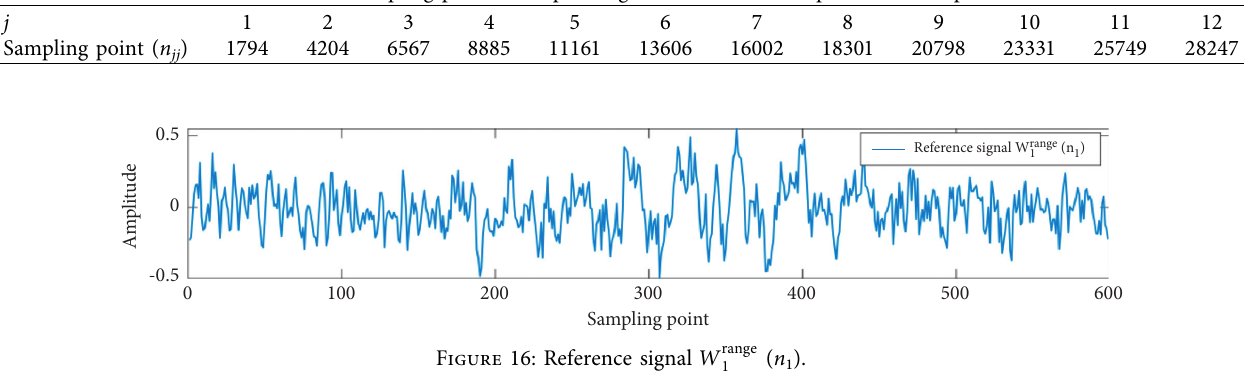
Figure 16: Reference signal W range Table 6: The optimal offset τ opt